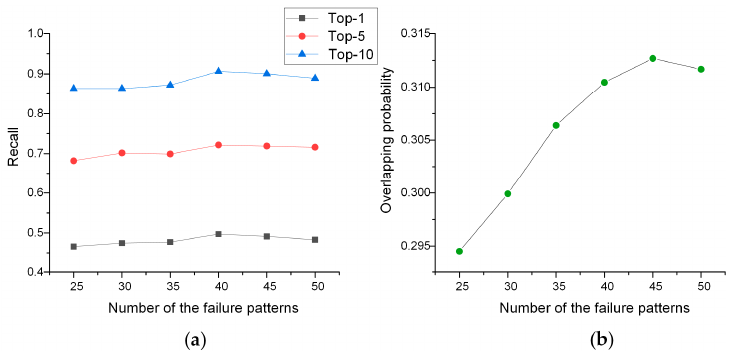
Figure 10. Performance comparison versus the number of failure patterns: ( a ) the Top-1, Top-5, and Top10 recalls with respect to the number of failure patterns. ( b ) the overlapping probability with respect to the number of failure patterns.